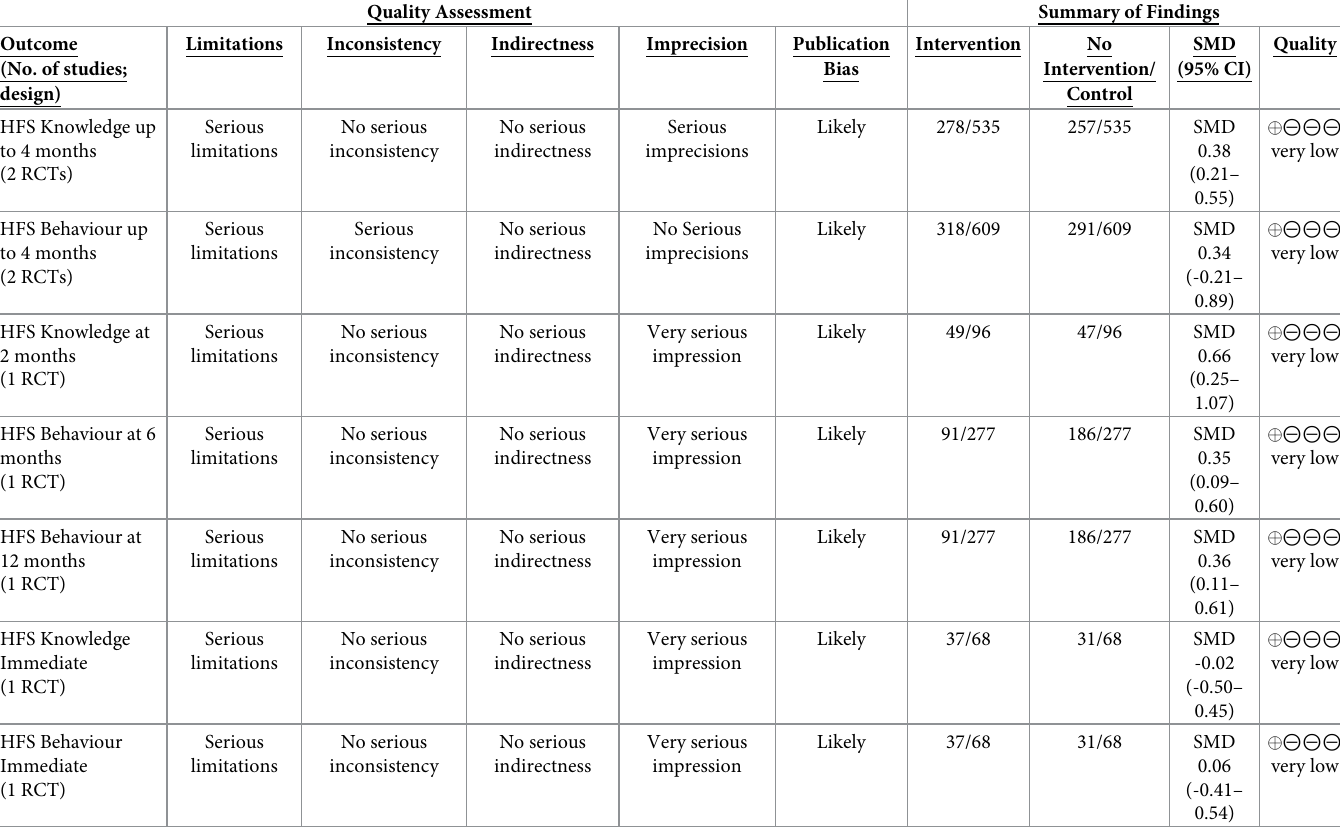
Table 3. GRADE evidence profile: Intervention vs no intervention/control.